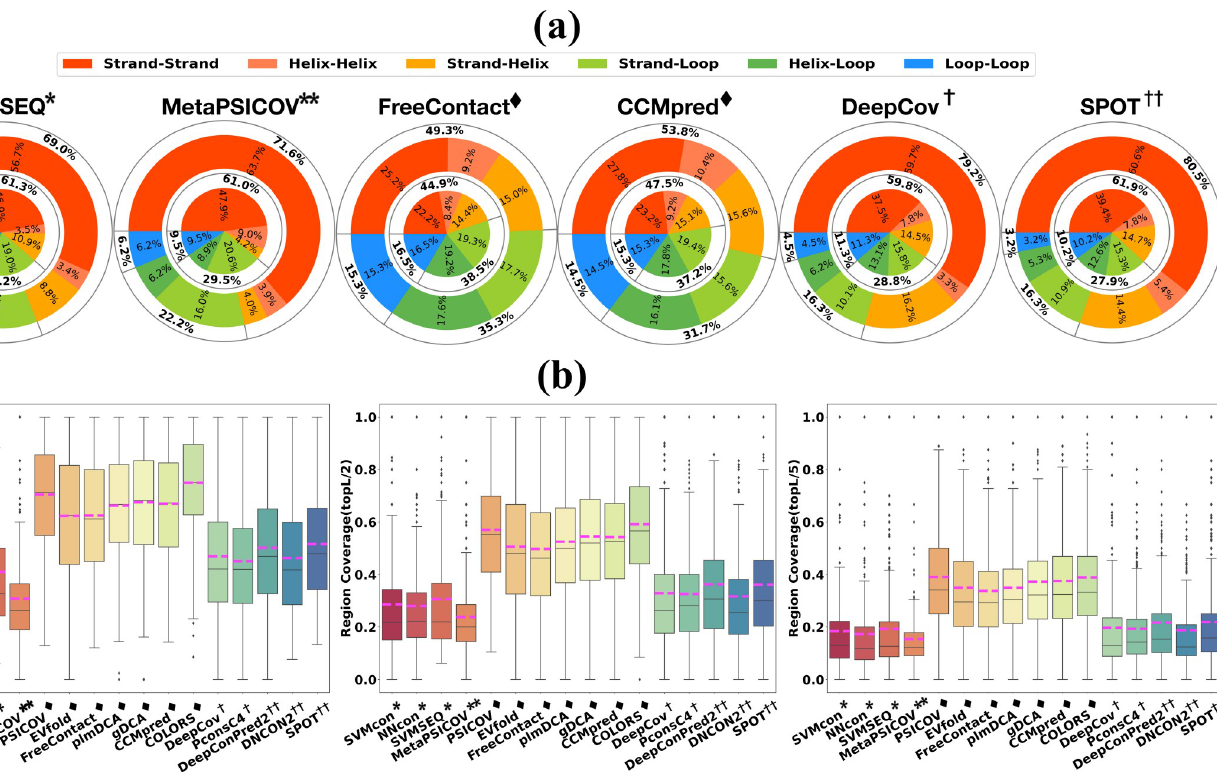
Fig 8. Secondary-structure-related prediction performance on TestSet1. (a) Prediction proportions of true positive contacts for different secondary structure types. The internal pie and external ring and show the proportions of strand-strand, helix-helix, strand-helix, strand-loop, helix-loop, loop-loop in top L and L/5 true positive predicted contacts, respectively. As the number of predictions decreases, supervised techniques are more inclined to predict higher ratios of strand-strand contact types. (b) The box plots from left to right show the prediction region (secondary structure interaction) coverage of top L, L/2 and L/5, respectively (the pink dashed line is the average prediction coverage of each method). DL methods makes use of contact occurrence patterns for accurate prediction, thus the prediction is less dispersed on secondary-structure-based regions when a limited number of top predictions are considered.